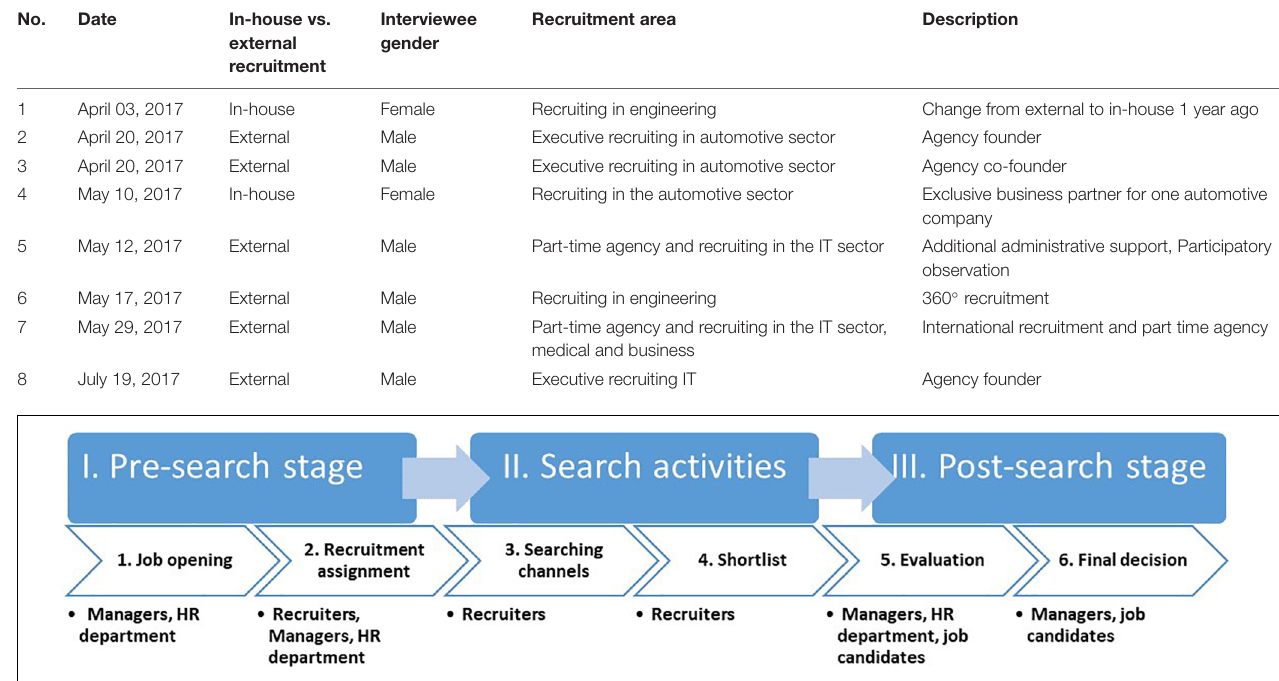
TABLE 1 | Sample description for the qualitative interview study. No.